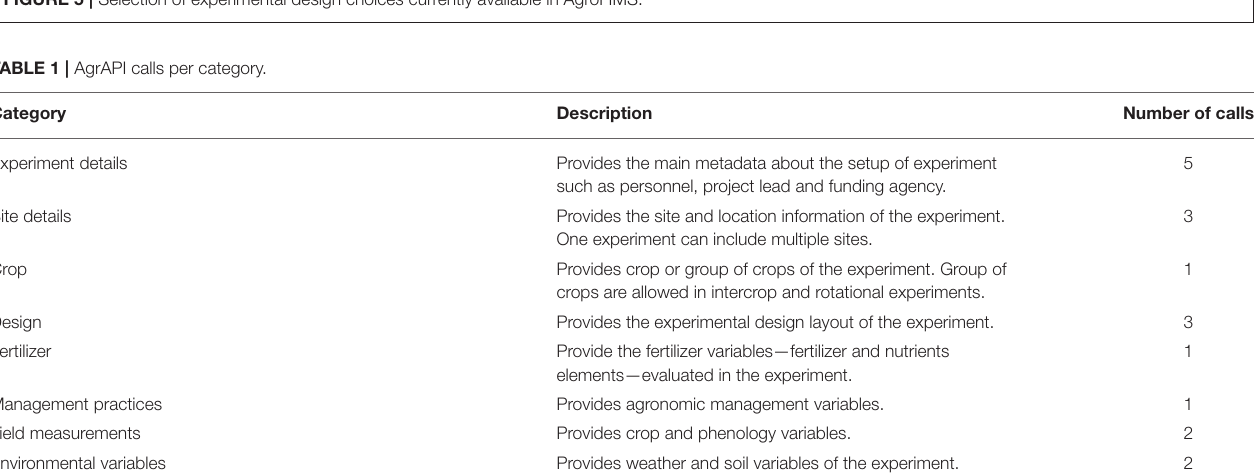
FIGURE 5 | Selection of experimental design choices currently available in AgroFIMS.